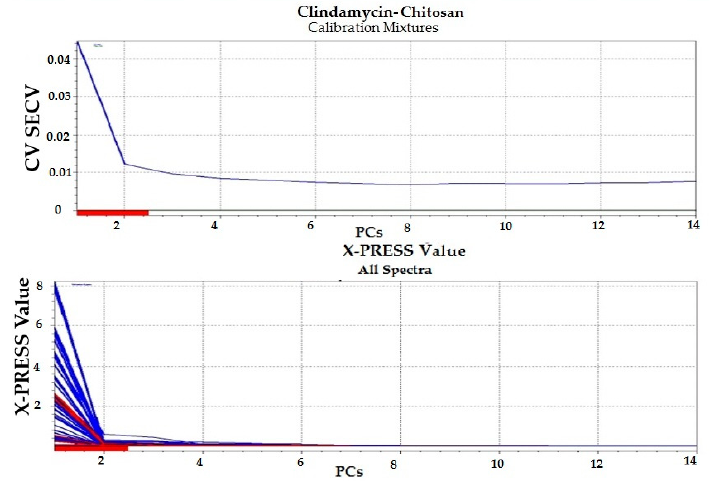
Figure 6. Selection of appropriate number of PLS components for clindamycin-chitosan calibration Figure 6. mixtures.